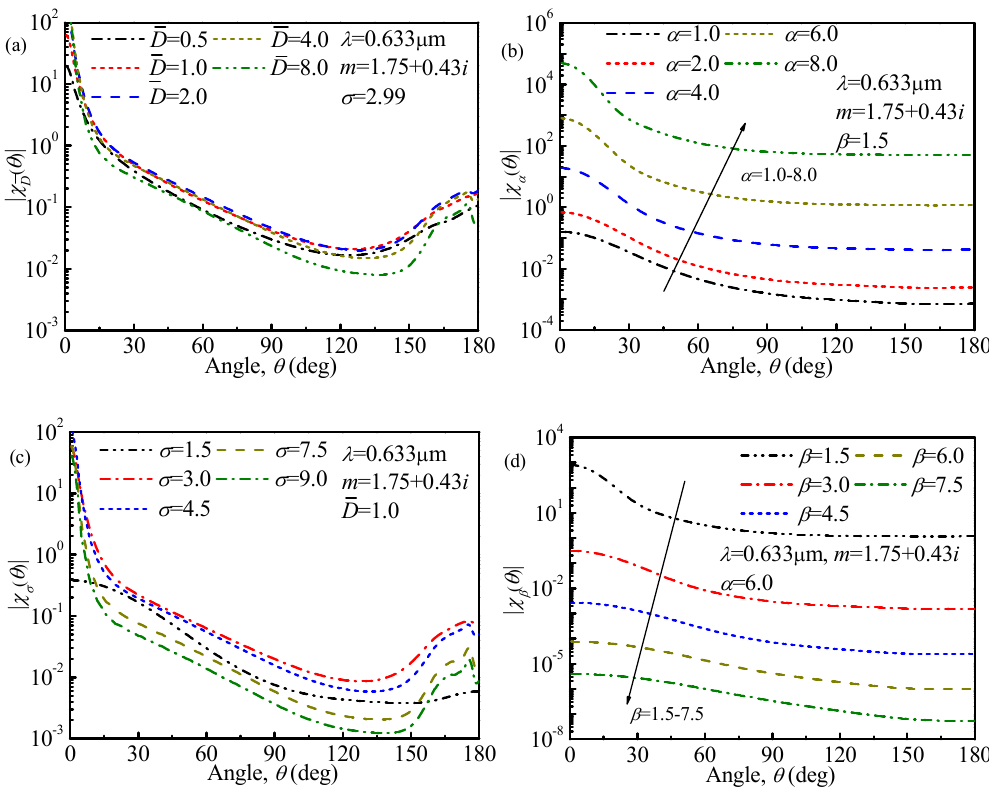
Figure 3. Sensitivity analysis of angular light-scattering signals to characteristic parameters in ASDs: ( a , c ) for L-N distribution, ( b , d ) for Gamma